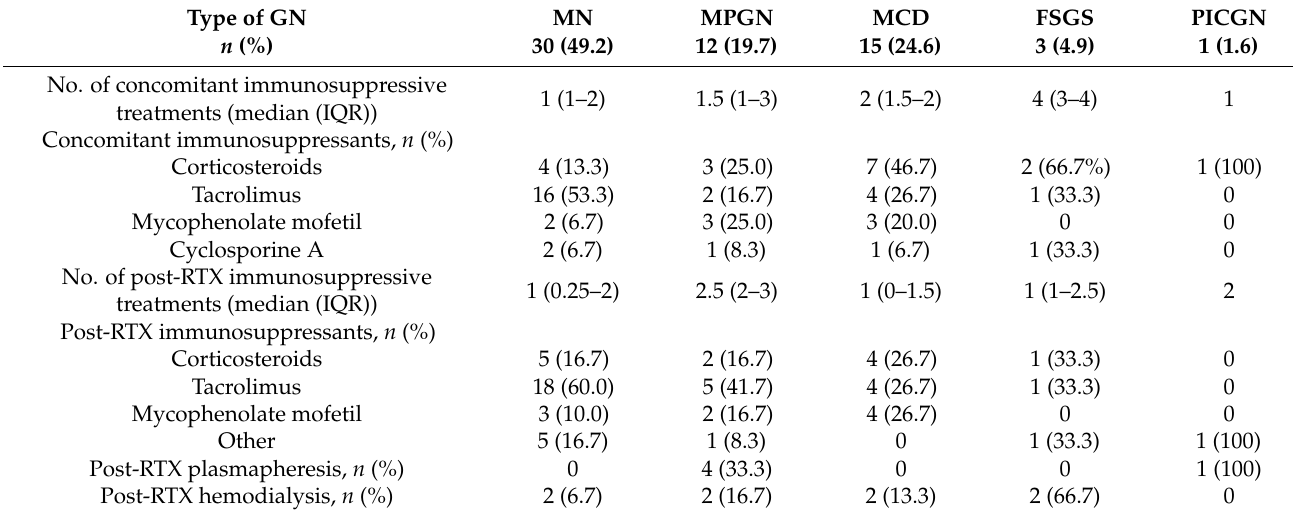
Table 4. Concomitant and post-RTX treatment.